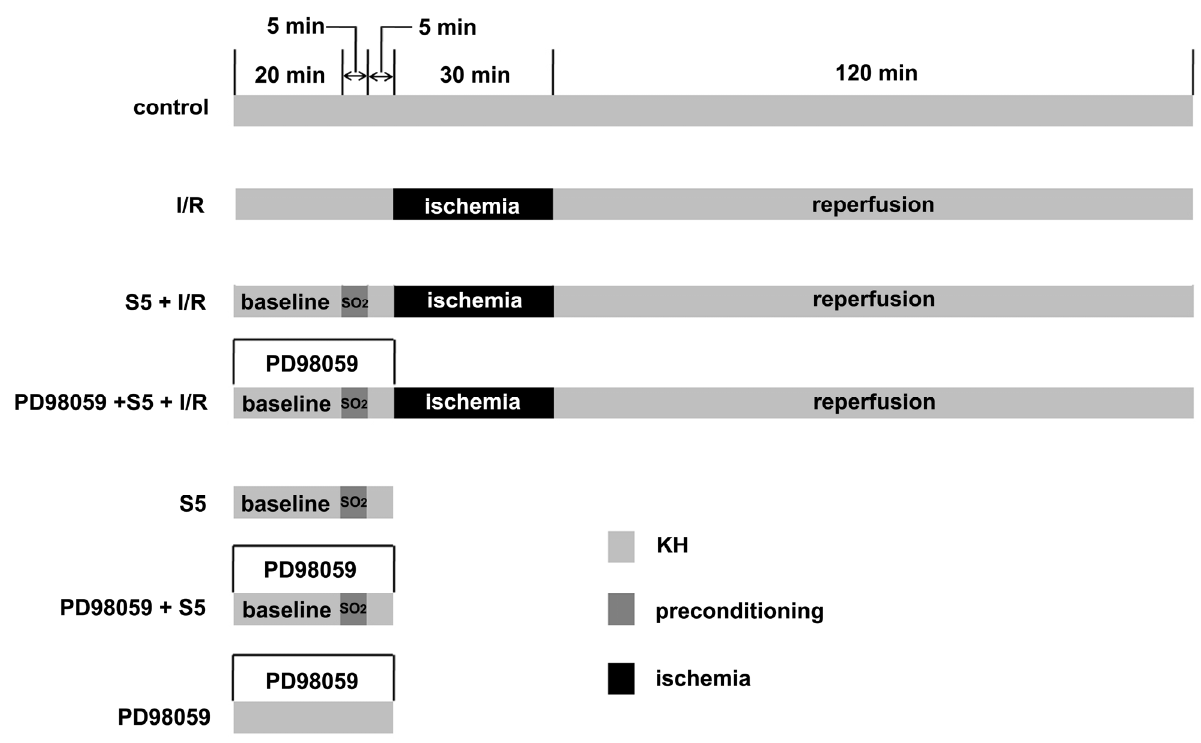
Figure 4. Heart perfusion procedure. Baseline: cardiac function change before ischemia. Ten min before ischemia, the rat heart was preconditioned with 5 μ mol/L SO 5 min. The heart was perfused with PD98059 for 30 min before ischemia. KH: